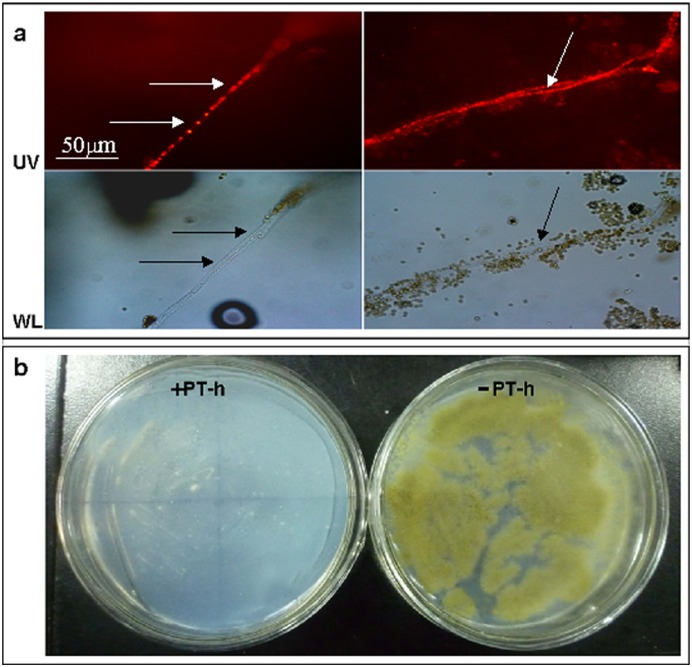
Lipid droplets accumulated in the mycelium of the reference strain A-4 (A) and the cell growth of strain A-4 grown on CD-plate without (-PT-h) and with 0.1 mg l−1 PT-h (+PT-h) (B).(A) Strain A-4 was cultivated on wheat straw and bran mixture for 6 days. The Nile red stained fermented products were then microscopic observed under ultraviolet (UV) and white light (WL); (B) Inhibitory effects of PT-h on the cell growth of A-4. Incubation was performed at 30°C for 5 days.